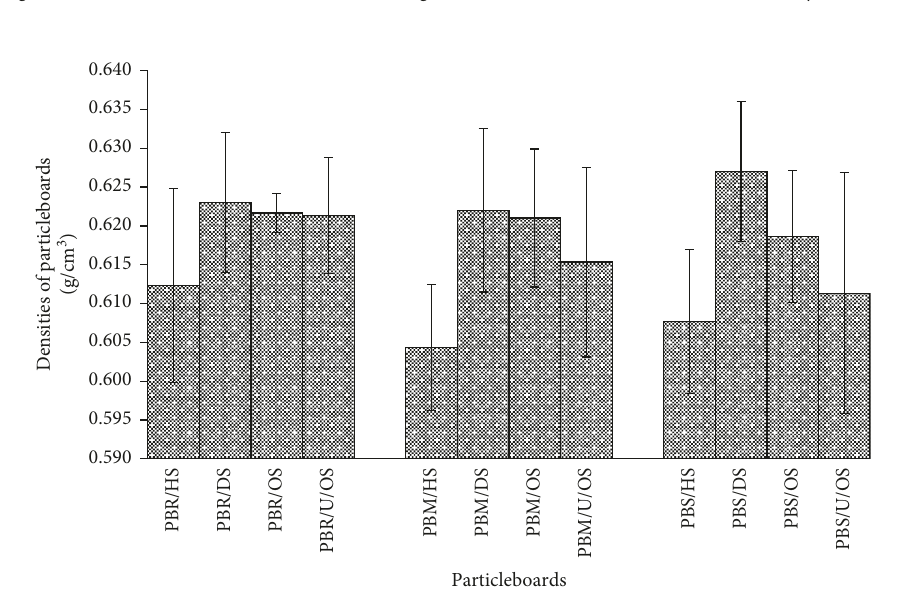
Figure 2: Average densities of particleboards and their standard deviation as error